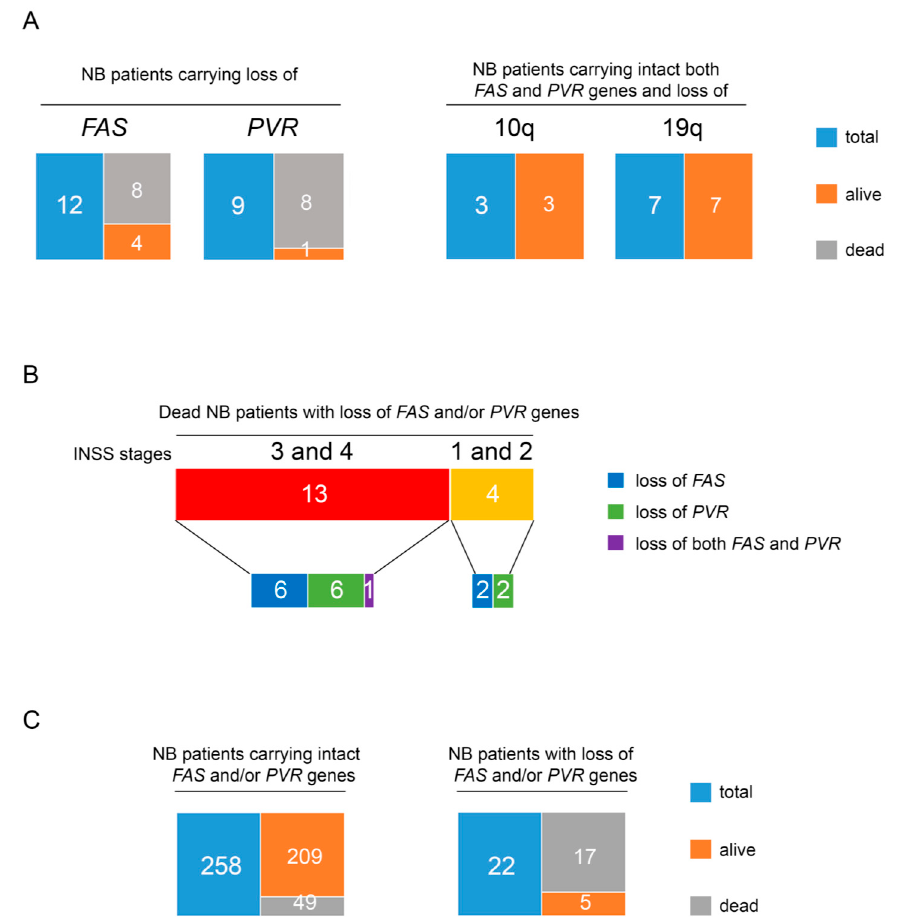
Figure 4. Loss of FAS and PVR in NB patients correlates with low survival regardless of disease stage. ( A ) Tree diagrams showing the number of alive and dead patients in NB case groups carrying loss of FAS or PVR genes (right panel) and those carrying both intact FAS and PVR genes and loss of chromosome 10q or 19q (left panel). ( B ) Tree diagrams showing the number of dead NB patients with loss of FAS or PVR or both genes at the INSS disease Stage 3 and 4 or 1 and 2. ( C ) Tree diagrams showing the number of alive and dead patients in the groups of NB cases carrying intact FAS and/or PVR genes (right panel) and those carrying loss of FAS and/or PVR genes (left panel).